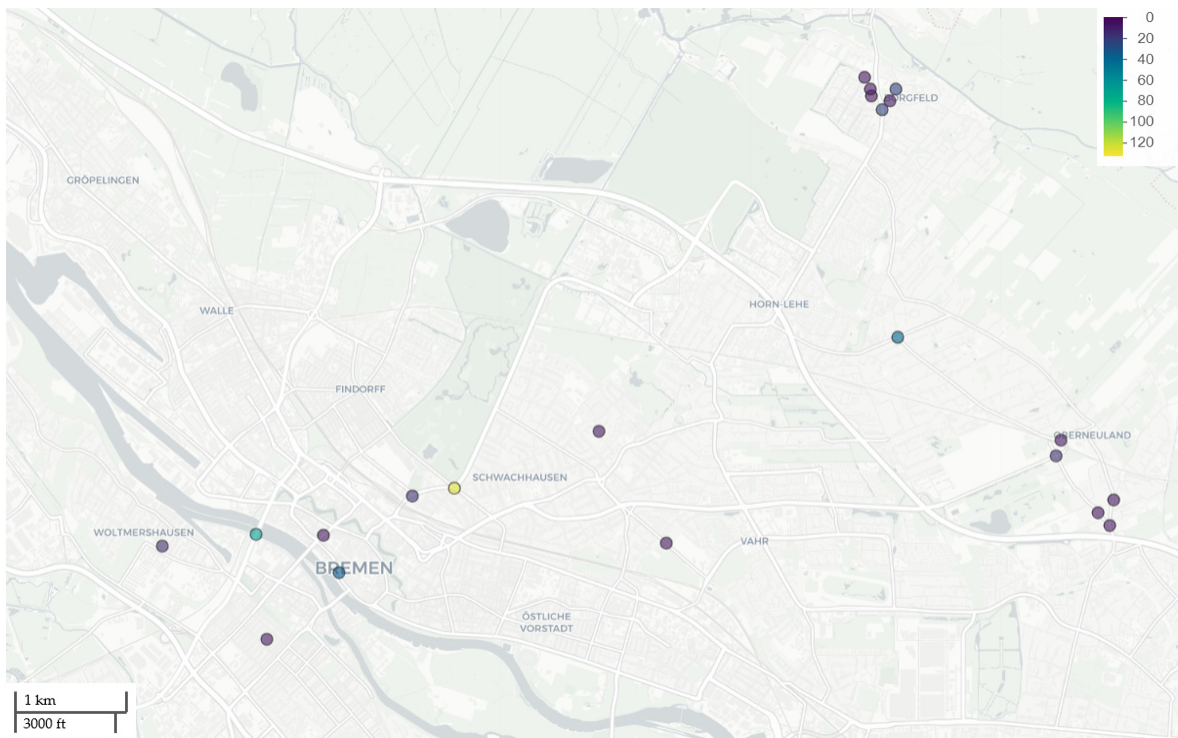
Figure A2. Map display of audited danger spots in Bremen and their respective number of collisions (property damage only).